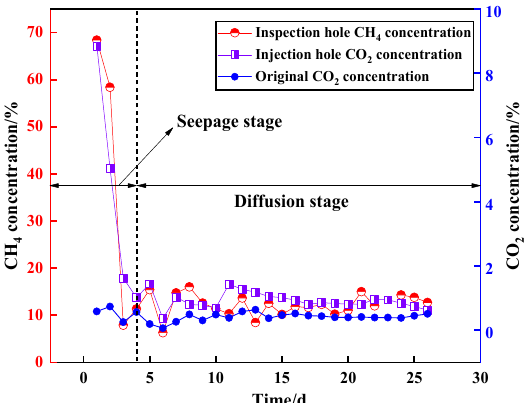
Figure 8. Relationship between CH 4 concentration and CO 2 concentration change.